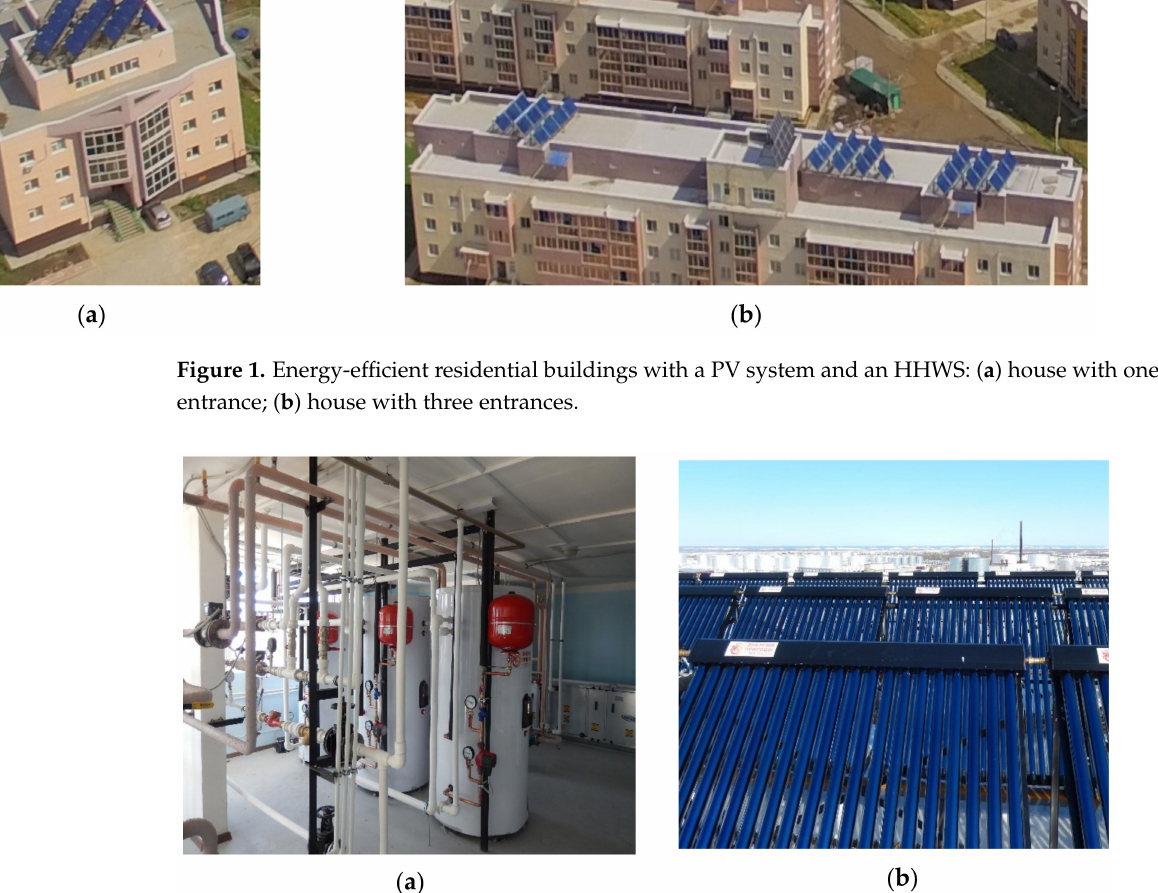
Figure 2. Engineering equipment for heat supply of apartment buildings: ( a ) hot water supply with one gas-fired boiler and three storage tanks; ( b ) arrangement of solar collectors, each consisting of 20 evacuated